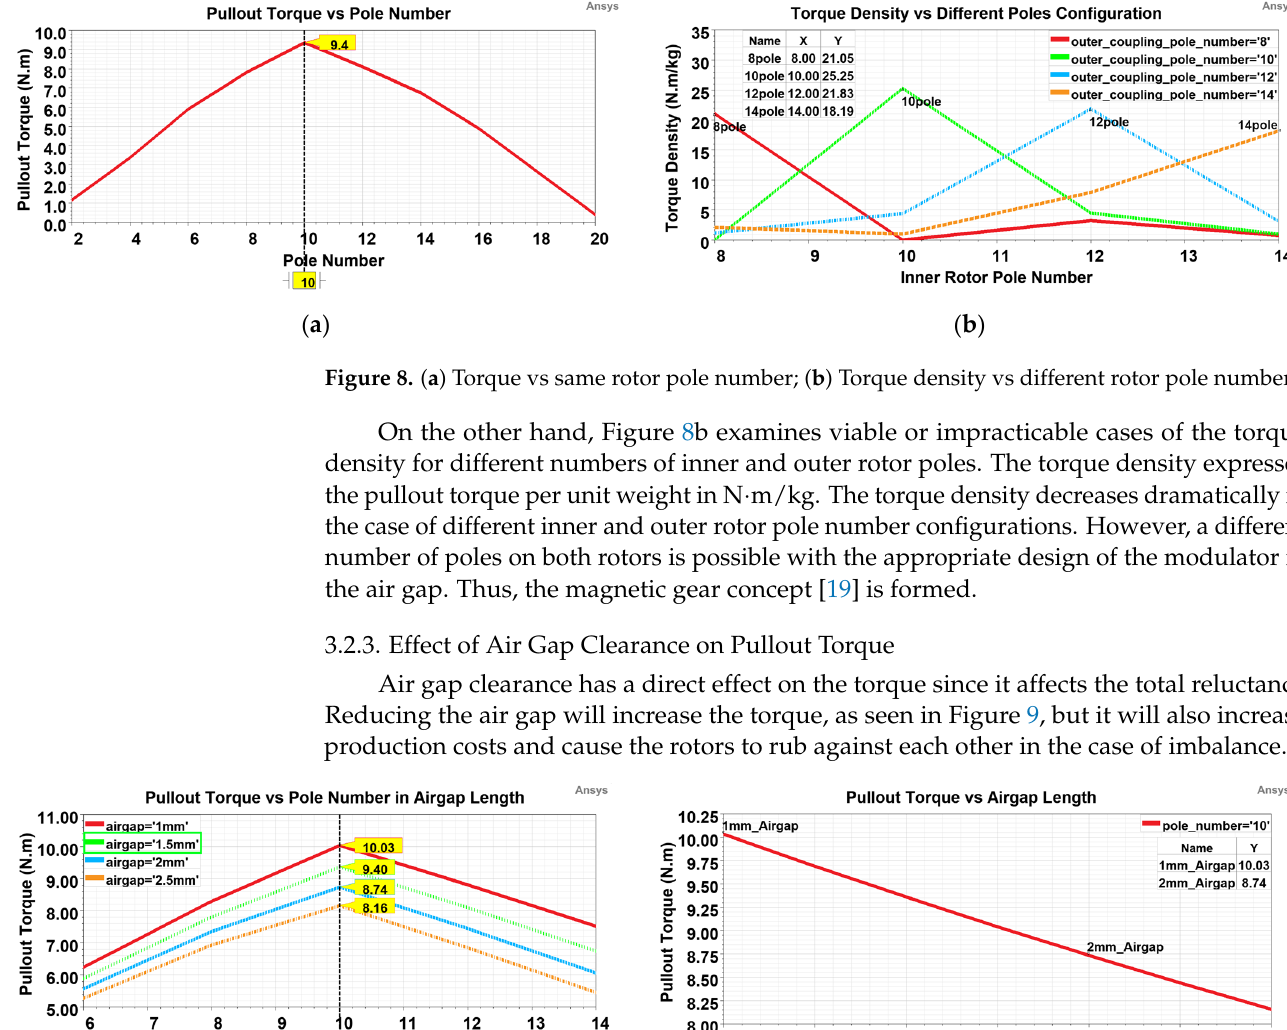
Figure 7. Pullout torque versus ( a ) Effective air gap length in model length; ( b ) Model length.